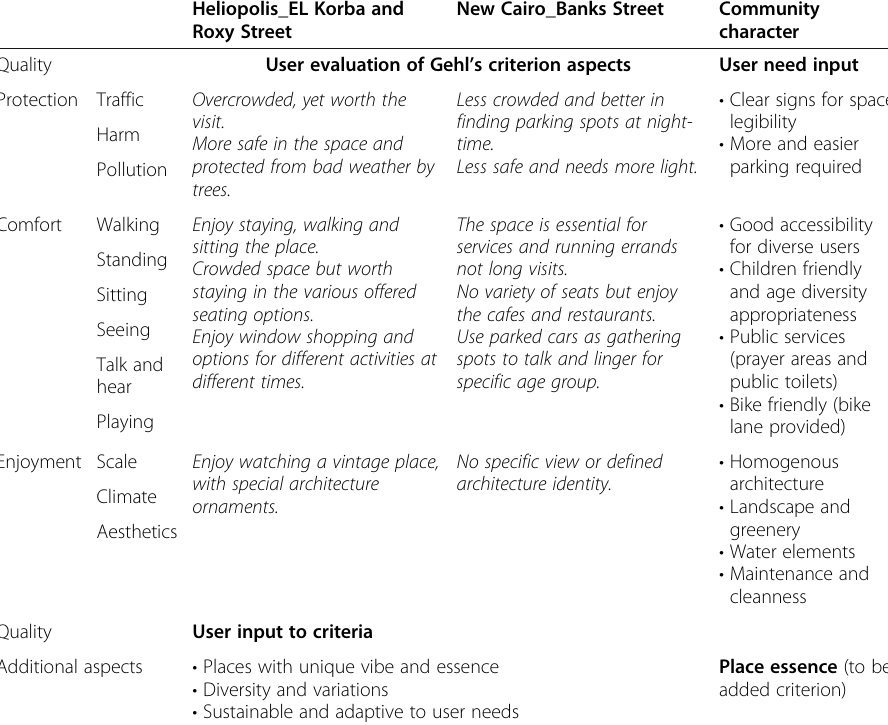
Table 4 User need input of Korba, EHliopolis and Banks Street, New Cairo public spaces survey results